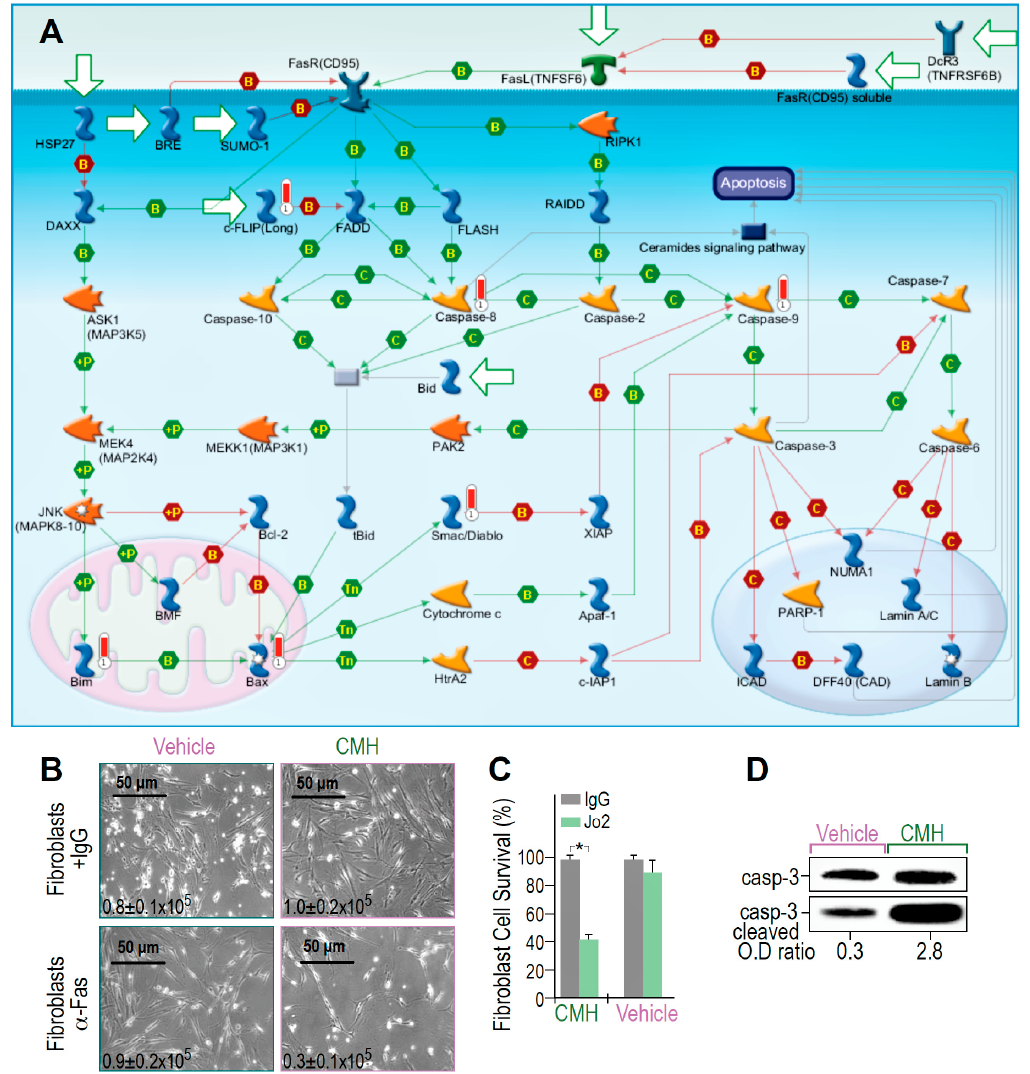
Figure 3. CMH increases SIRT1-regulated Fas- cell death and Fas- cascades in IPF-lung myofibroblasts. Survival pathways in RNA-seq and specific gene changes of CMH (30 µ M), and fold ratio to vehicle (4% DMSO) in the IPF-lung myofibroblast CCL-191 cell line. ( A ) MetaCore Fas pathway maps (Genego Inc., St Joseph, MI, USA). Cell death and Fas / FasL cascade pathway analyses; + P, green arrows—increased phosphorylation; red thermometer—increased activity and overexpression of genes. ( B ) Light microscopy images with trypan blue exclusion (inserted numbers), and ( C ) Percentage of fibroblast survival, following anti-human Fas mAb-mediated cell death, in CMH-, or control (vehicle)-treated lung fibroblasts; n = 4, p < 0.05. ( D ) Caspase-3 cleavage in WB of CMH vs. vehicle and Jo2 (20 µ g, 48 h) anti-Fas mAb-treated IPF lung myofibroblasts in the CCL-191 cell line. Representative of four experiments.